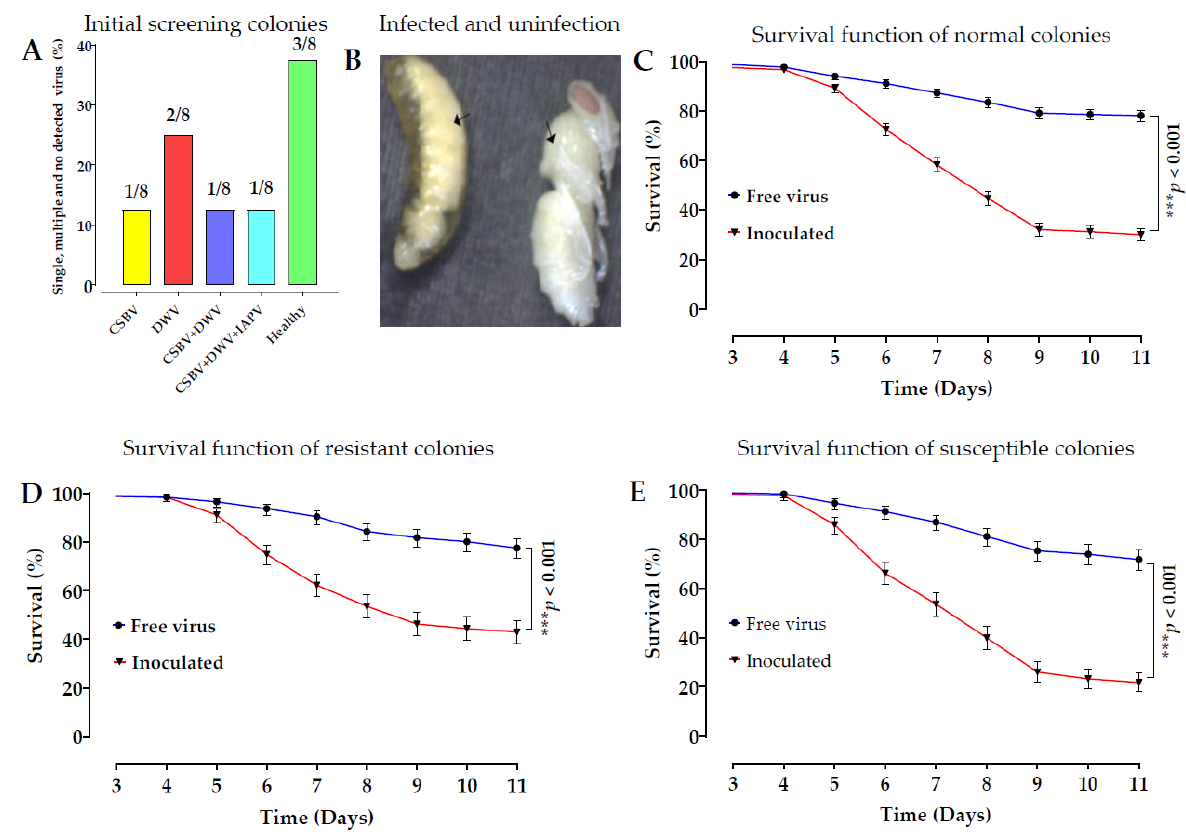
Figure 1. Screening colonies, infected and uninfected larva, and probability survival function. ( A ) Screening candidate colonies against seven common bee viruses. Based on RT–PCR detection of